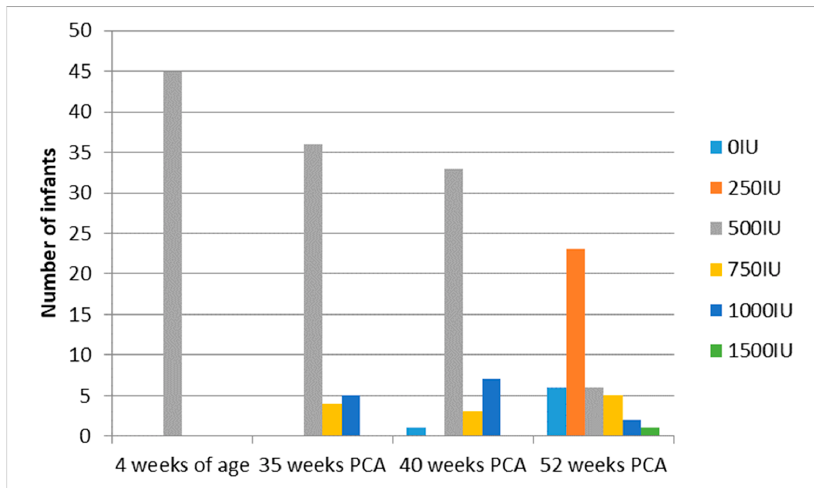
Figure 3. Scheme modified vitamin D supplementation in the monitored group. Table 2. Changes in Vitamin D supplementation and their influence on serum concentration in the monitored group.